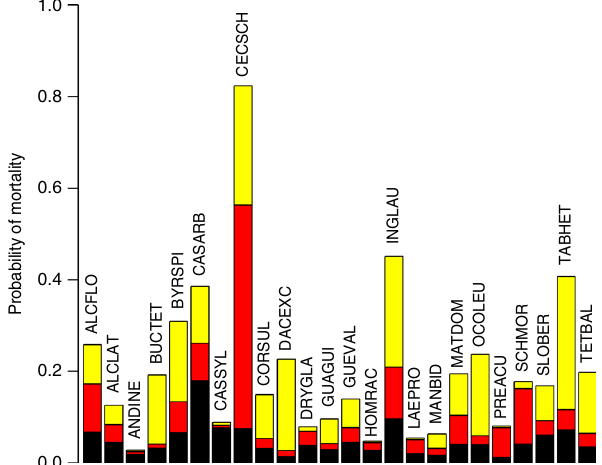
Fig. 5 Background (black) and hurricane-induced mortality, immediate (red) and delayed (yellow), from Hugo. Delayed mortality rates are estimated for trees ≥ 10 dbh that were present at the time of the storm and damaged and died between the completion of the damage assessment in 1991 and the 1995 census. Background mortality represent tree mortality over the same period for undamaged Lagged tree mortality from hurricane damage . Windstorms are prominent causes of tree mortality 15 . Background mortality rates for trees > 10 cm diameter at breast height in wet tropical forests range between 1 and 2% per year and rarely exceed 3% 15 – 17 .